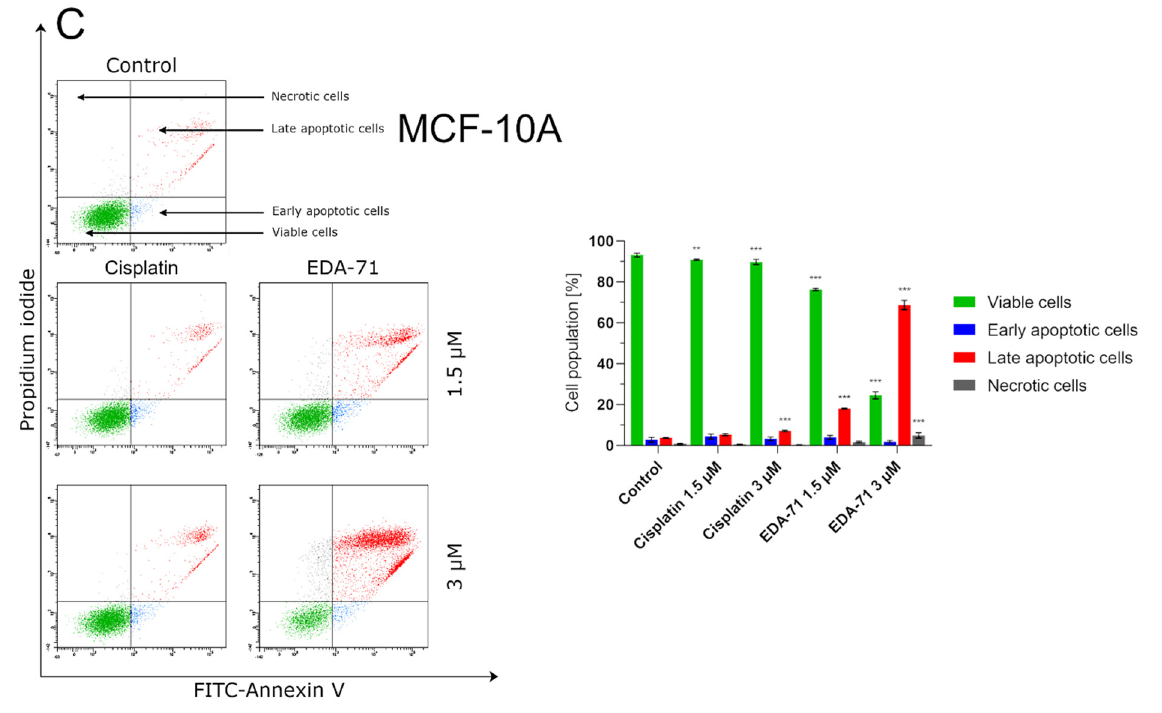
Figure 4. Induction of apoptosis in MCF-7 ( A ) and MDA-MB-231 ( B ) breast cancer cells and MCF-10A normal breast epithelial cells ( C ) incubated for 24 h with EDA-71 and cisplatin (1.5 and 3 µM). The experiment was performed using Annexin V-FITC/propidium iodide double staining and a flow cytometer. Results are presented as mean values ± SD obtained from three independent experiments ( n = 3) conducted in triplicate. Statistical differences between the experimental (treated cells) and control (untreated cells) groups were determined using one-way ANOVA followed by Dunnett’s test. ** p < 0.01 vs. control group, *** p < 0.001 vs. control group.